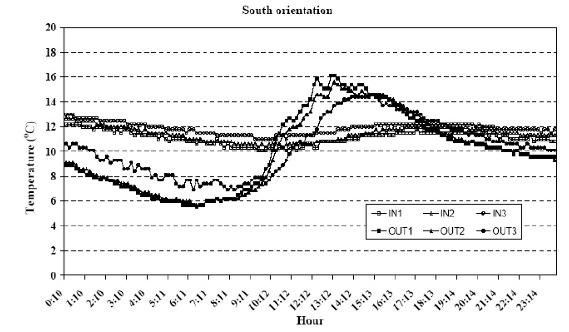
Figure 8. Temperature distribution inside and outside at east wall Winter period